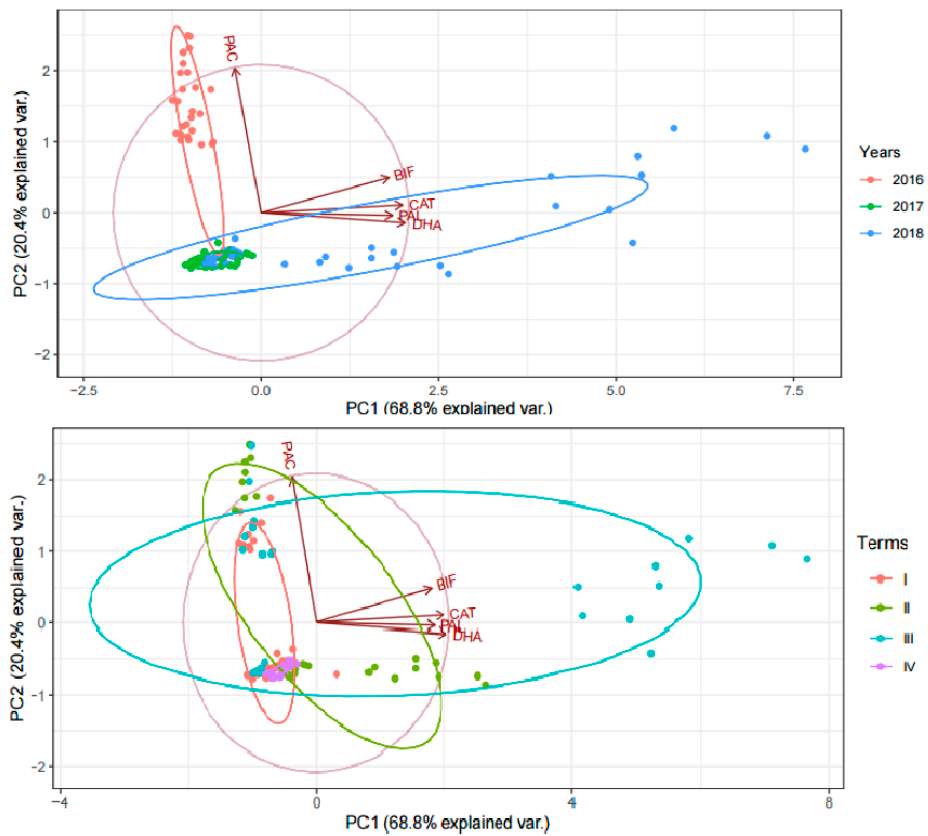
Figure 9. The dependence between the soil enzymatic activity and all treatments with fertilizers and bio-stimulants at the terms of analyses. Abbreviation: I term—at the plants’ emergence (BBCH 5–10), II term—at the plants’ full growth (BBCH 35–40), III term—at the at the plants’ florescence (BBCH 51–59), IV term—after harvest. BIF—index of fertility, CAT—catalase activity, PAC—acid phosphomonoesterases, PAL—alkaline phosphomonoesterases, DHA—dehydrogenase activity.